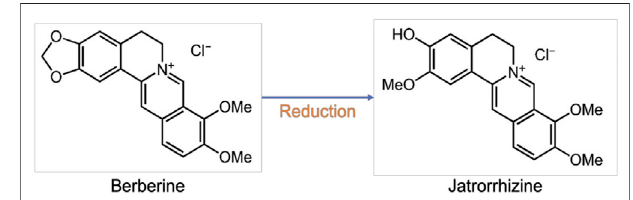
FIGURE 2 | Structures of berberine and